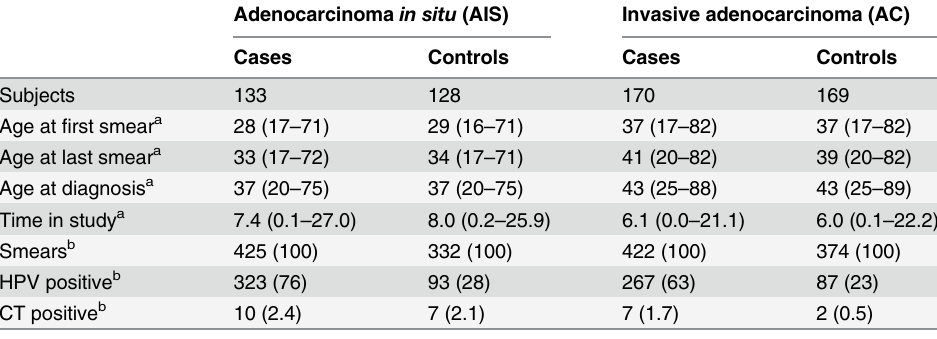
Table 1. Study population and distribution of C . trachomatis positive smears between cases and con- trols, for all β -globin-positive smears collected in the study.